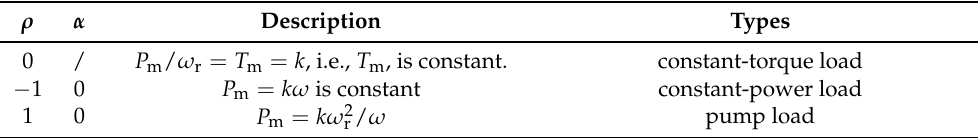
Table 1. Different types of mechanical loads for induction